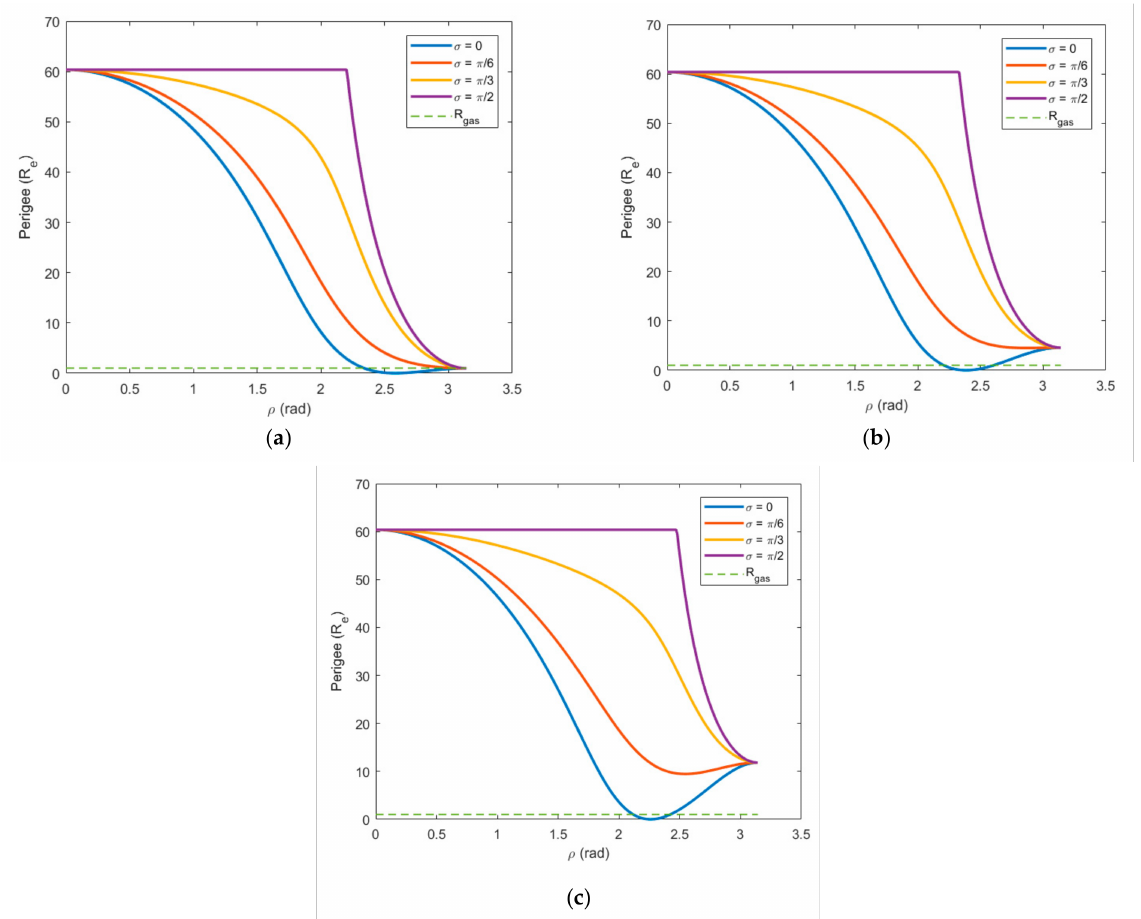
Figure 8. The variation in the perigee radius with ρ when v ∞ > v moon . ( a ) v ∞ = 1.2 km/s; ( b ) v ∞ = 1.4 km/s; ( c ) v ∞ = 1.6